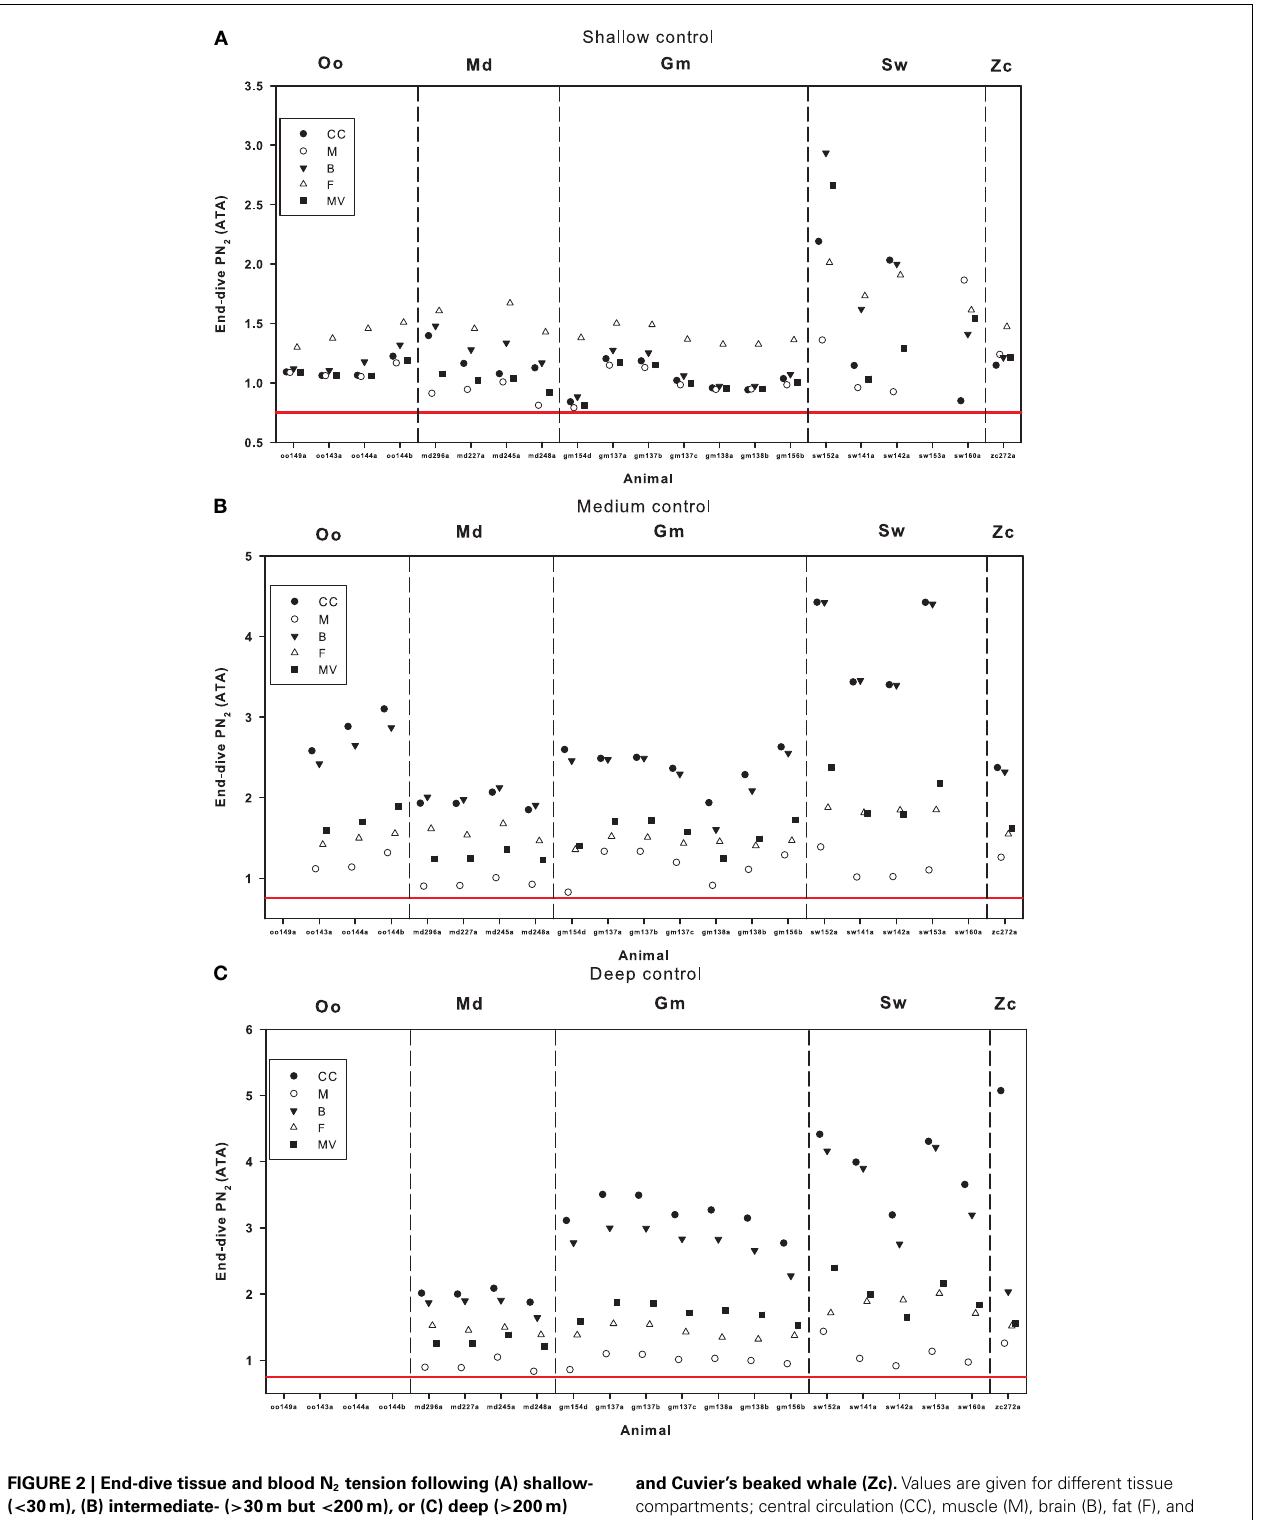
FIGURE 2 | End-dive tissue and blood N 2 tension following (A) shallow- ( < 30m), (B) intermediate- ( > 30m but < 200m), or (C) deep ( > 200m) dives in the pre-exposure control period for killer whales (Oo), Blainville’s beaked whales (Md), pilot whales (Gm), sperm whales (Sw),